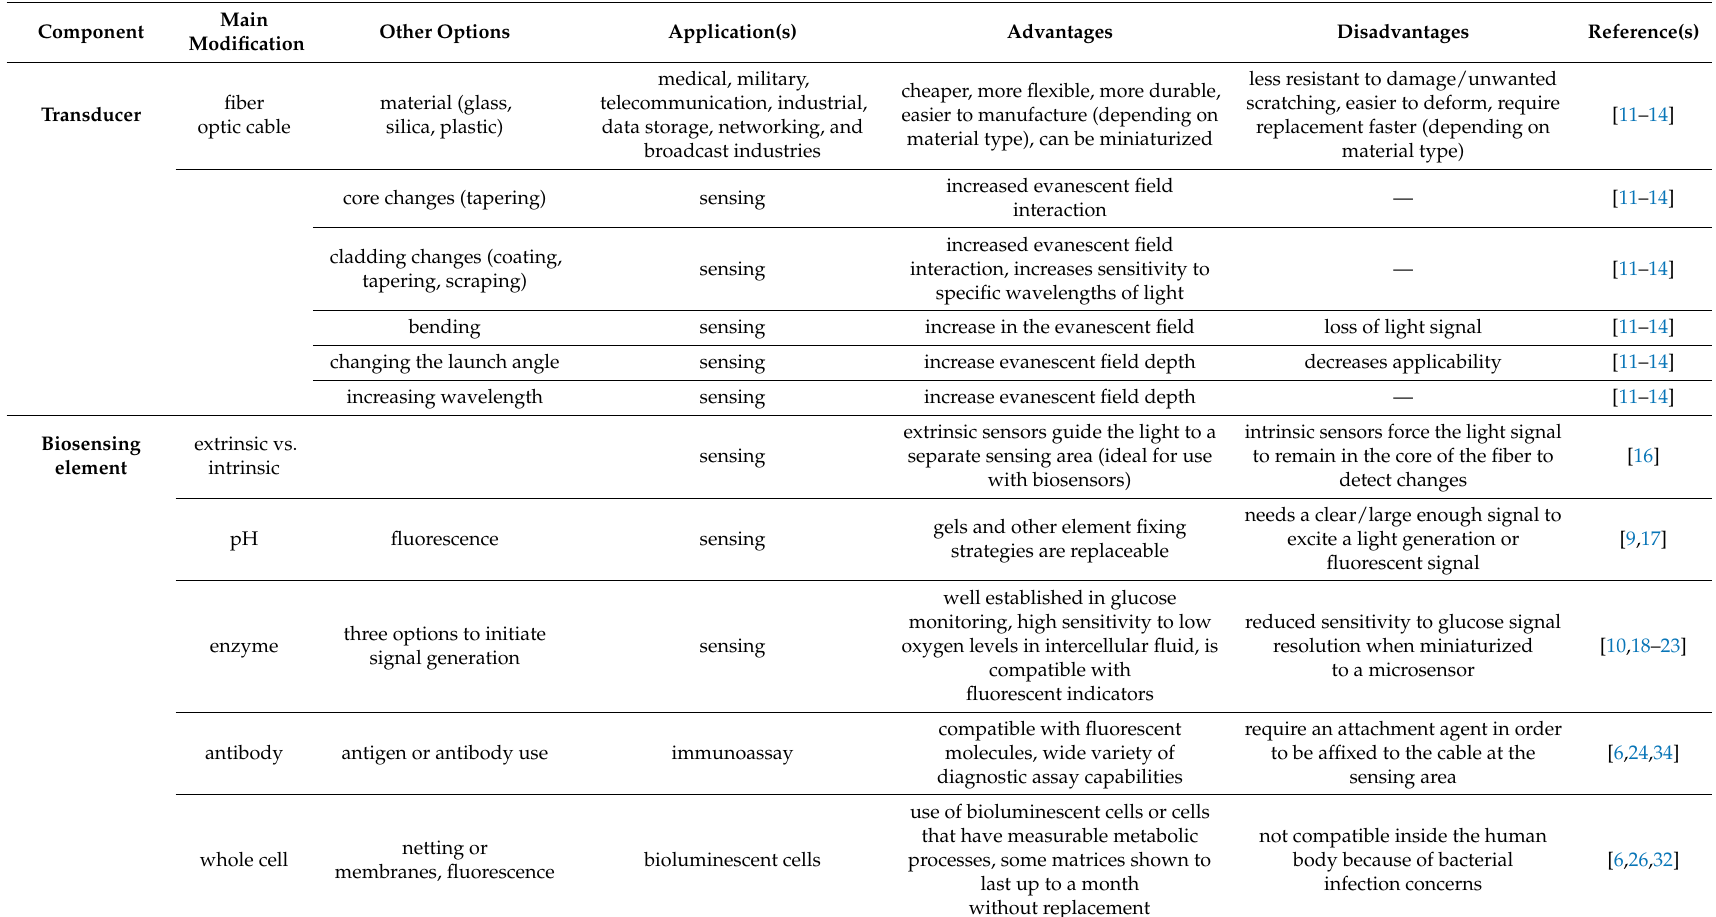
Table 1. Summary of FOBS components and